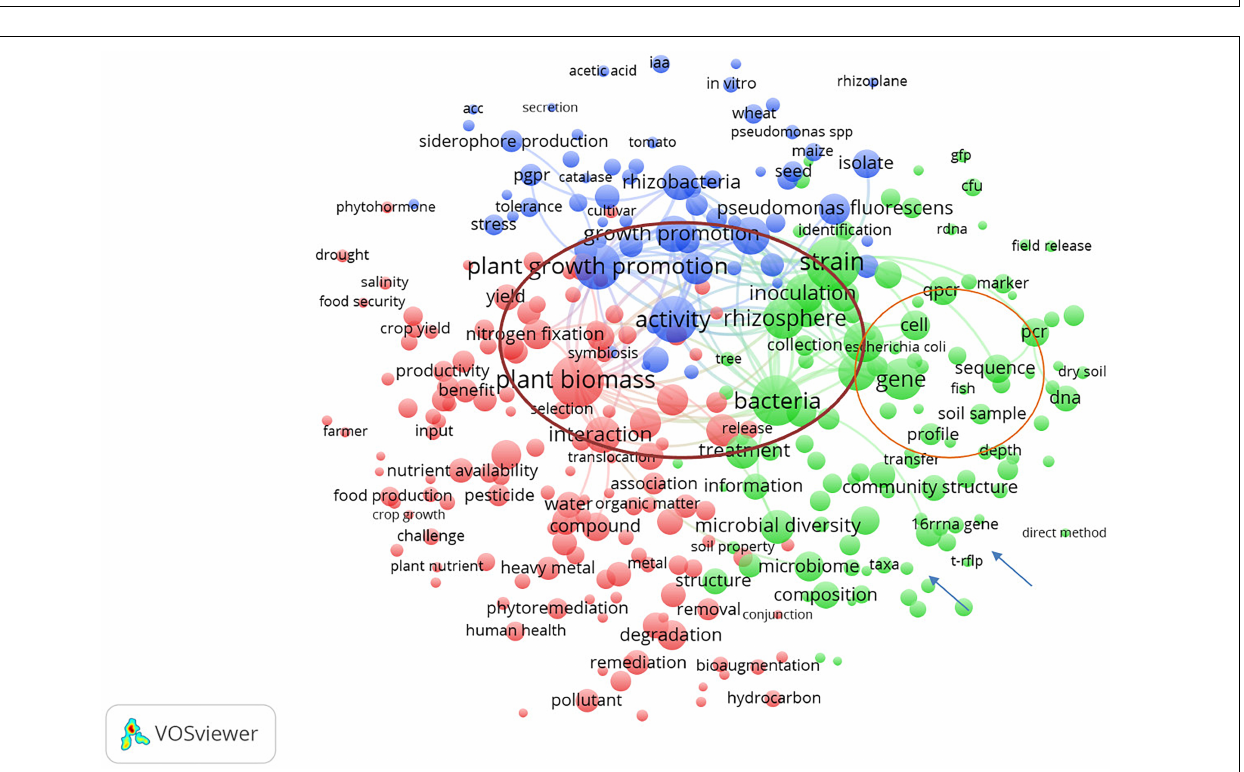
FIGURE 1 | Trend of publications on soil microbial inoculants tracking and monitoring in the period from 1991 to 2020. The blue line represents the number of publications per year; the orange line represents the frequencies of publications per year.